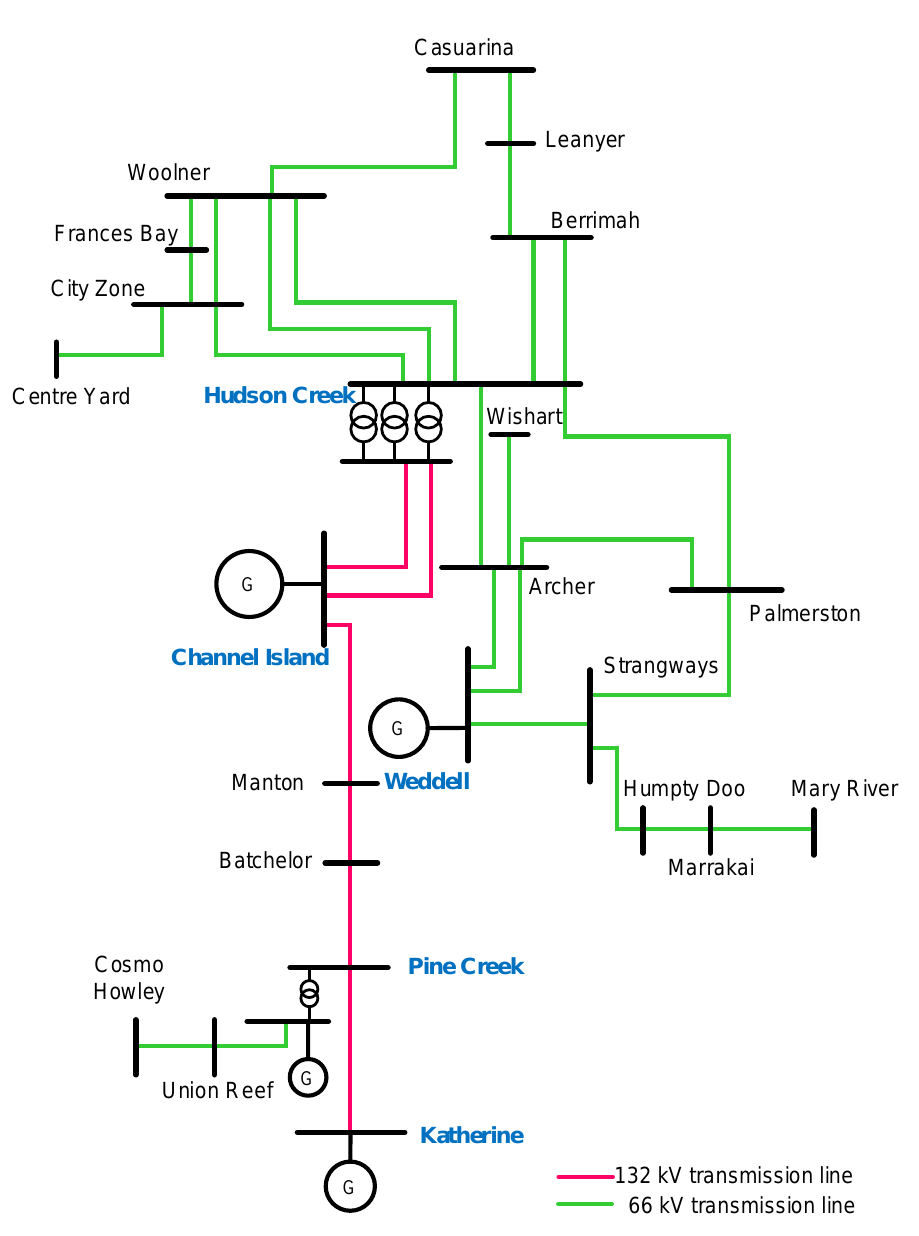
Figure 3. Single line diagram of Darwin–Katherine transmission network. The information required to build the network model was collected from different sources. The lines and transformers data were provided by PWC. Further, thermal capacity of the lines was extracted from [33]. Daily load profiles with the resolution of 30 min for dry and wet seasons were extracted from [33] for all substations in Darwin–Katherine region. The DKIS has a sustainable installed capacity of just over 500 MW. The fuel type of the generation units is made up of a mix of dual fuel (gas/diesel), gas only, steam and landfill gas. The generation plants are Channel Island (310 MW), Weddell (129 MW), Katherine (35 MW), Pine Creek power station (27 MW) and Shoal Bay (1.1 MW). The details of generation units in the Darwin–Katherine region such as their make, engine type, fuel type and MW rating can be found in [32]. The 30 min generation dispatch of of all generating units in Darwin–Katherine region are provided in [34]. The